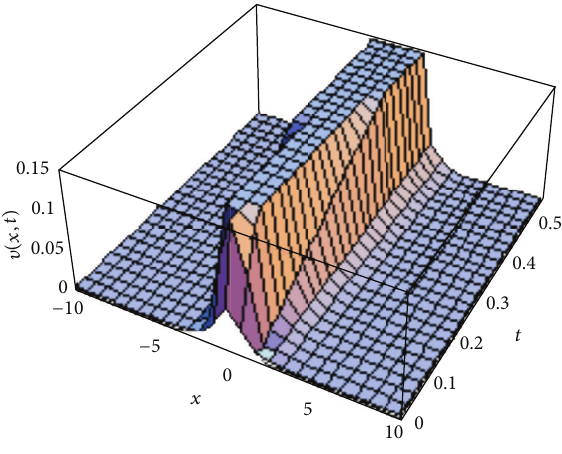
Figure 1: Approximate solution for 𝛼 = 0.75 and 𝛽 = 0.45 .